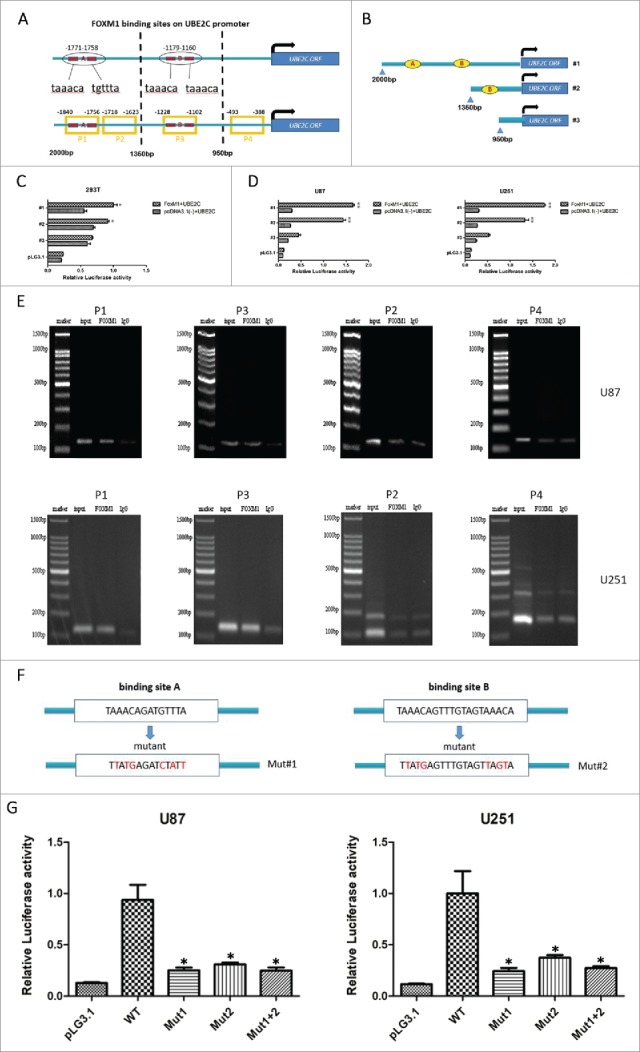
FoxM1 binds to and activates the UBE2C promoter. (A) The predicted sequences of putative FoxM1-binding sites in the −2000 bp region of the UBE2C promoter by gene sequence analysis. (B) The schematic representation of constructs harboring different fragments in the −2000 bp region of the UBE2C promoter. (C) The Dual Luciferase reporter assay showed the relative promoter activities of each construct in 293T cells; *p < 0.05, **p < 0.01. Each construct was cloned into the basic pGL3 firefly luciferase reporter vector. (D) The Dual Luciferase reporter assay showed that different reporter plasmids covering different regions of the UBE2C promoter mediated the transcriptional activities of FoxM1 in U87-MG and U251 cells. (E) The ChIP results clearly revealed the binding activities of FoxM1 on the UBE2C promoter region. In U87-MG and U251 cells, the amounts of promoter DNA that were associated after ChIP were quantitated by qRT-PCR using four pairs of primers (P1/P2 and P3/P4). IgG was used as a negative control. (F) Schematic representation of the FoxM1-binding sites; sequences are shown in both the wild-type and mutant forms. (G) Mutational analysis of the predicted FoxM1-binding sites with the wild-type and mutant reporter plasmids in U87-MG and U251 cells; *p < 0.001.